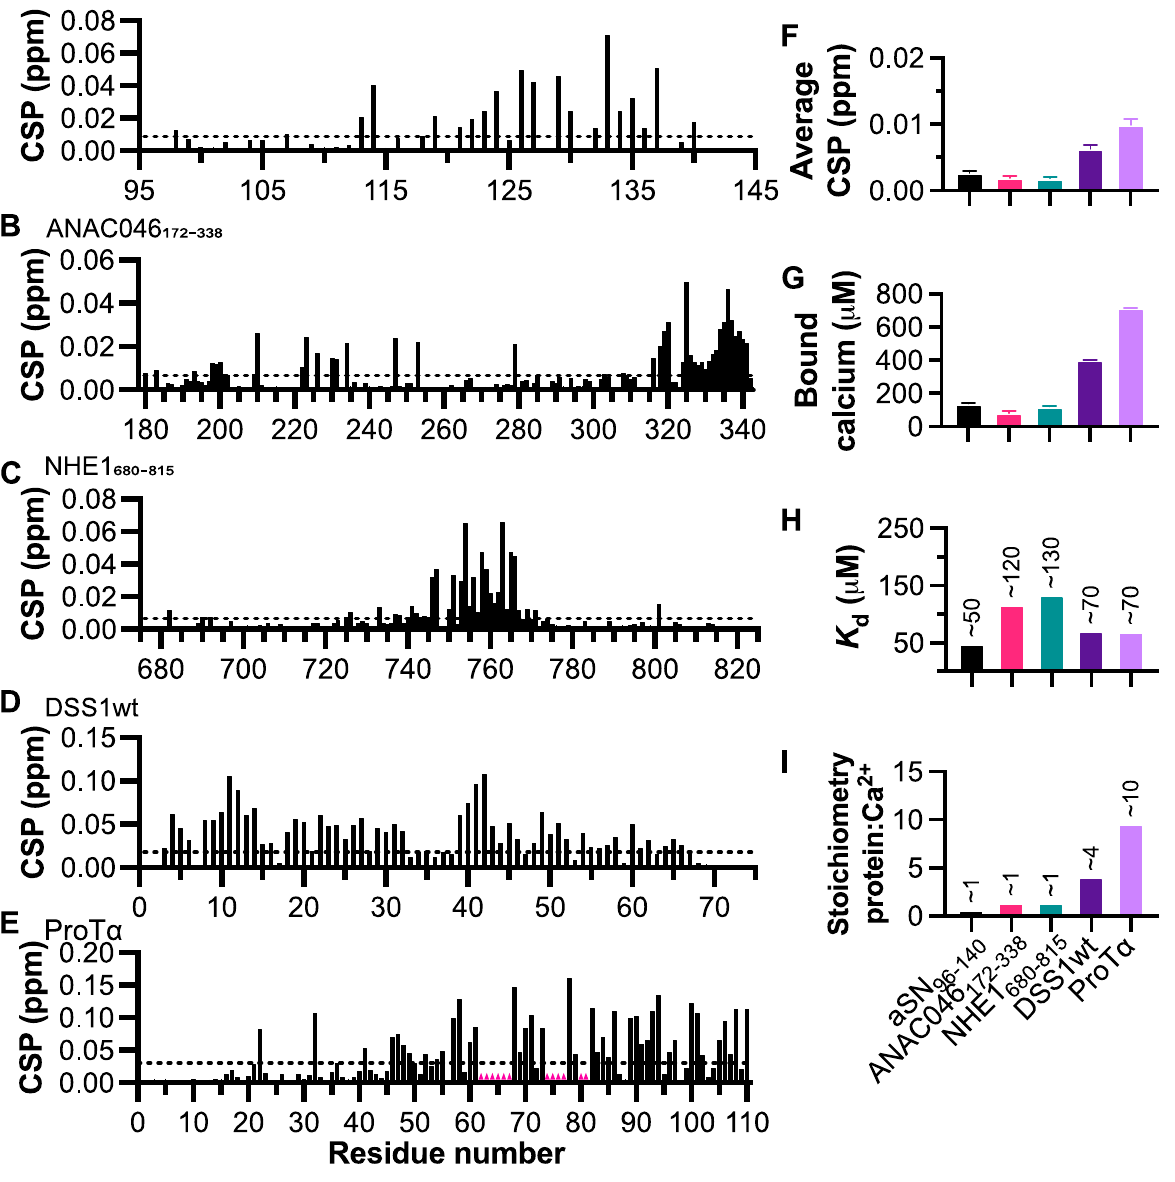
Figure 1. Calcium binding measured by NMR and OCPC absorption. Combined amide (N, H N ) CSPs observed in different IDPs (50 μ M) following addition of CaCl 2 (2.5 mM; Figure S2). ( A ) CSPs caused by the addition of CaCl 2 (2.5 mM) to aSN 96-140 , ( B )ANAC046 172-338 , ( C ) NHE1 680-815 , ( D ) DSS1wt, and ( E ) ProT α . ( F ) Averaged CSPs induced by EDTA (2.5 mM). ( G ) Concentration of cal- cium bound by the above proteins (100 μ M), as measured by the OCPC assay. ( H ) K d and ( I ) stoi- chiometry as calculated from Scatchard plots for each protein (see Figure S3). Error bars indicate SEM.